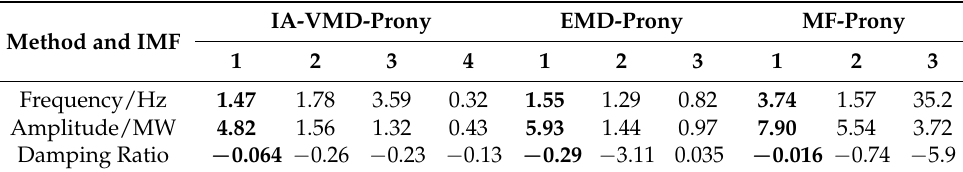
Table 3. Modal identification of the ambient